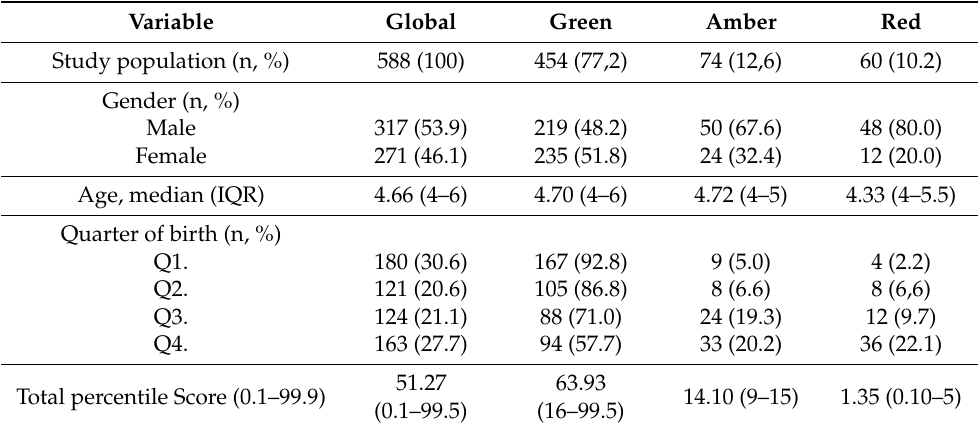
Table 1. Baseline characteristics.